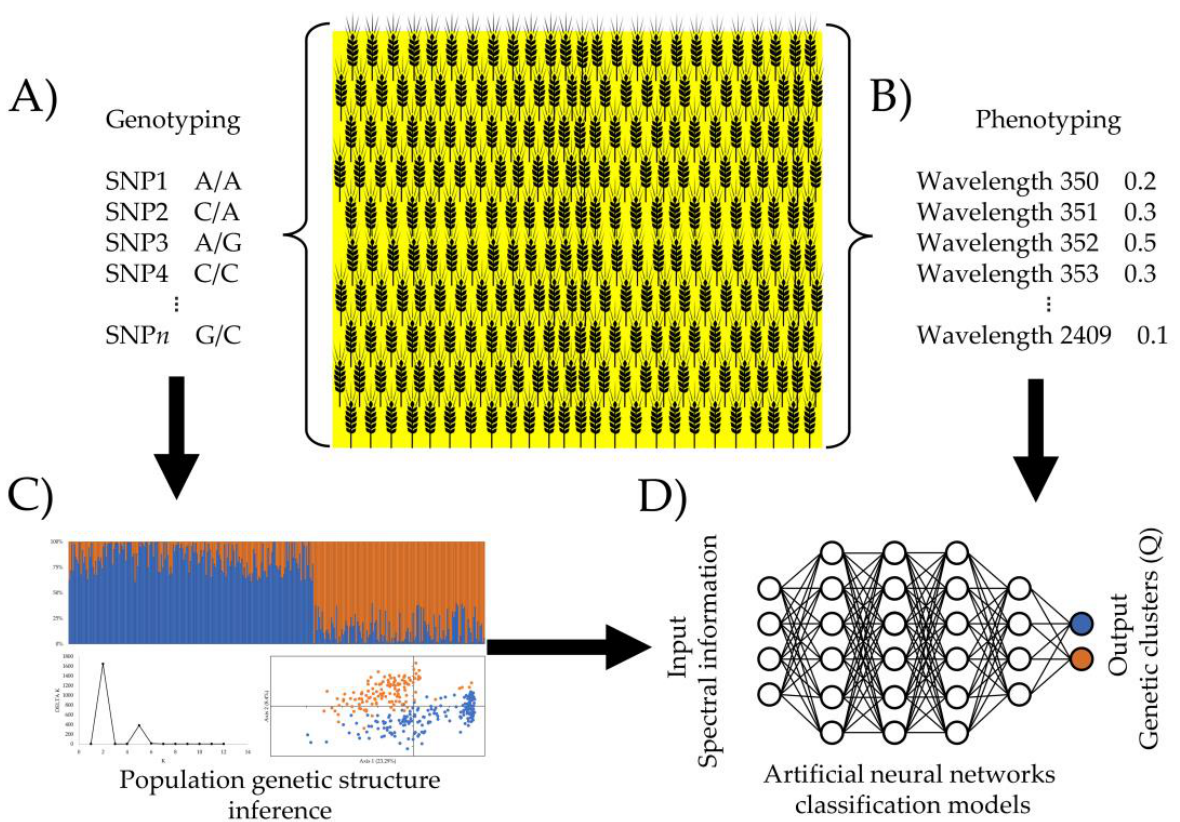
Figure 3. Overview of the spectral-based classification of genetically differentiated groups performed in this study. ( A ) Genotyping (using SNPs molecular markers) and ( B ) high-throughput phenotyping of the entire wheat panel (colored in yellow). ( C ) Molecular markers information is used to infer the population structure (cluster 1 (blue) and cluster 2 (orange)). ( D ) Training and validation of neural networks-based classification models (MLP and CNN).